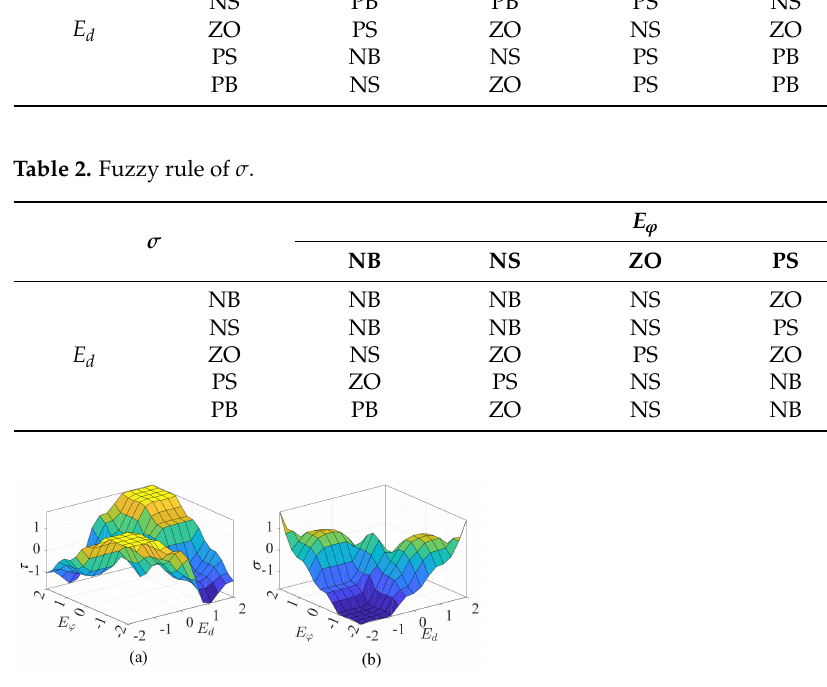
Figure 17. The output surface of control factors τ and σ : ( a ) τ ; ( b ) σ